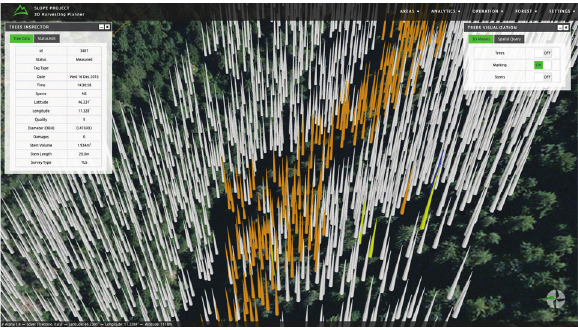
Figure 10. Forest inventory with tree status colouring and property inspection